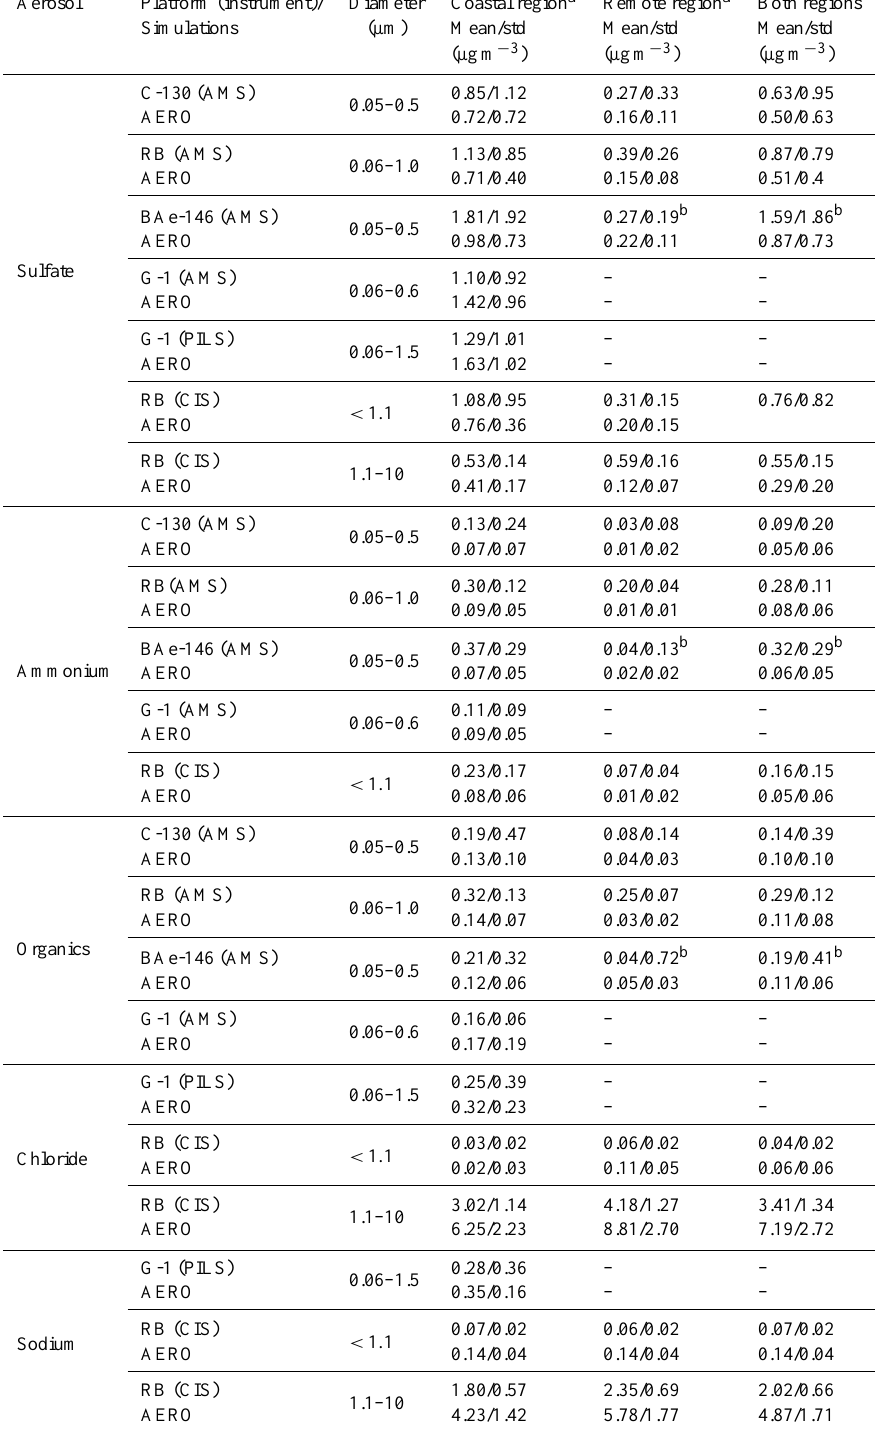
Table 4. Observed and simulated MBL submicron and supermicron aerosol composition. Aerosol